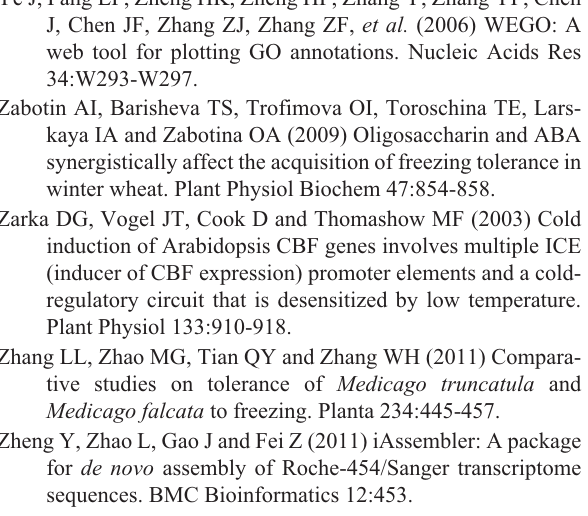
Figure S1 - Sequence identity distribution of alfalfa uni- genes. Figure S2 - Diagrammatic distribution of alfalfa transcripts. Figure S3 - qRT-PCR validation of 10 MsERF genes. Figure S4 - Expression models of four JAZ genes. Table S1 - List of qRT-PCR validation primers used in the present study. Table S2 - Functional enrichment analysis of GO terms. Table S3 - Transcripts homologous to AP2/ERF genes dif- ferentially expressed. Table S4 - Hormone-related transcripts that were differen- tially